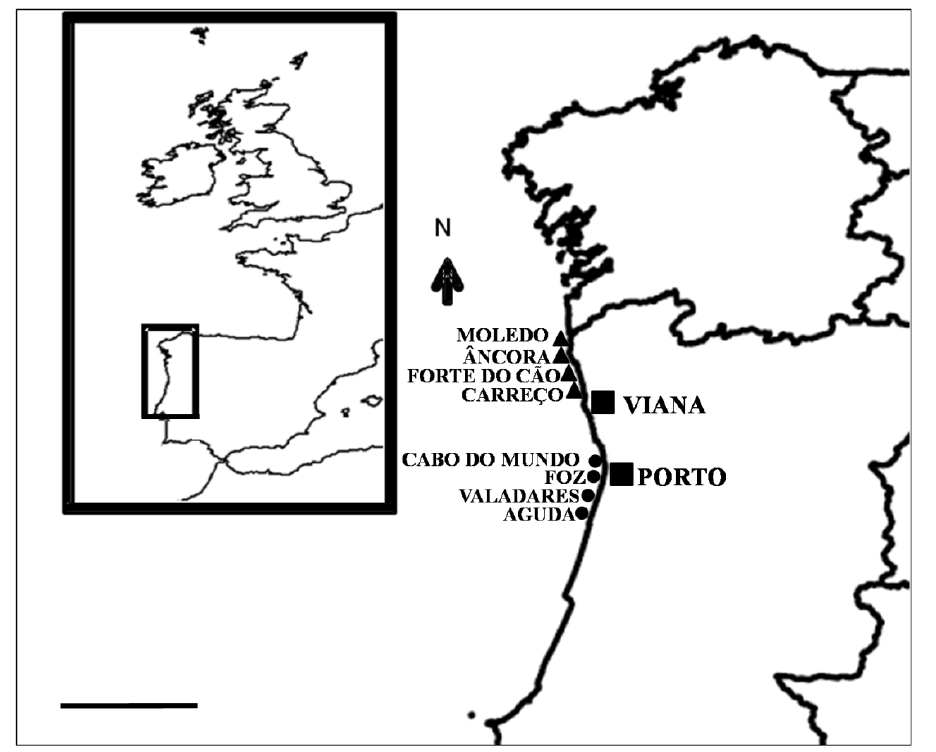
Figure 1. Situation of the study area showing the location of sampled shores (triangles) and the harbor of Porto and Viana (squares). Scale bar 50 km.